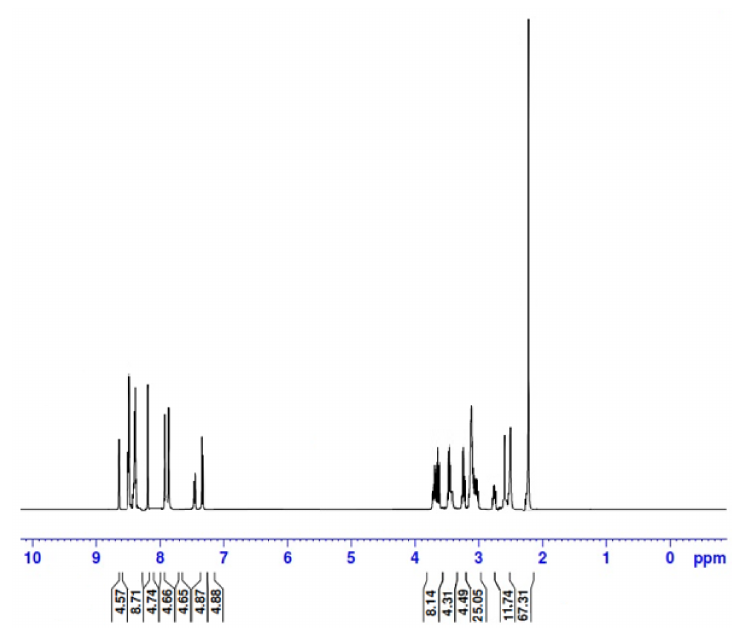
Figure 7. 1 H NMR spectrum of the Zn 2+